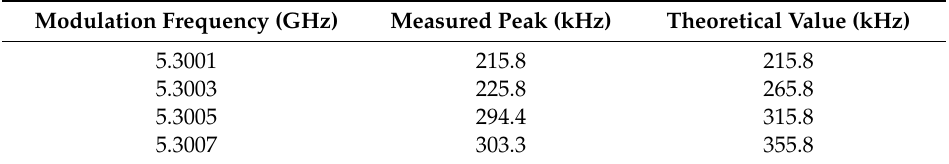
Table 3. The measured peak frequencies compare to the theoretical